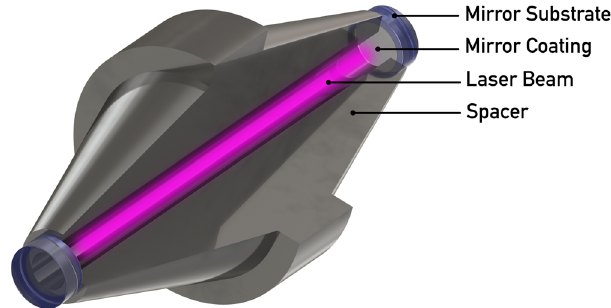
Fig. 1 Artistic representation of a high- fi nesse optical cavity. Shown is a laser stabilization cavity consisting of spacer, mirrors and coatings. Based loosely on ref. 18 .